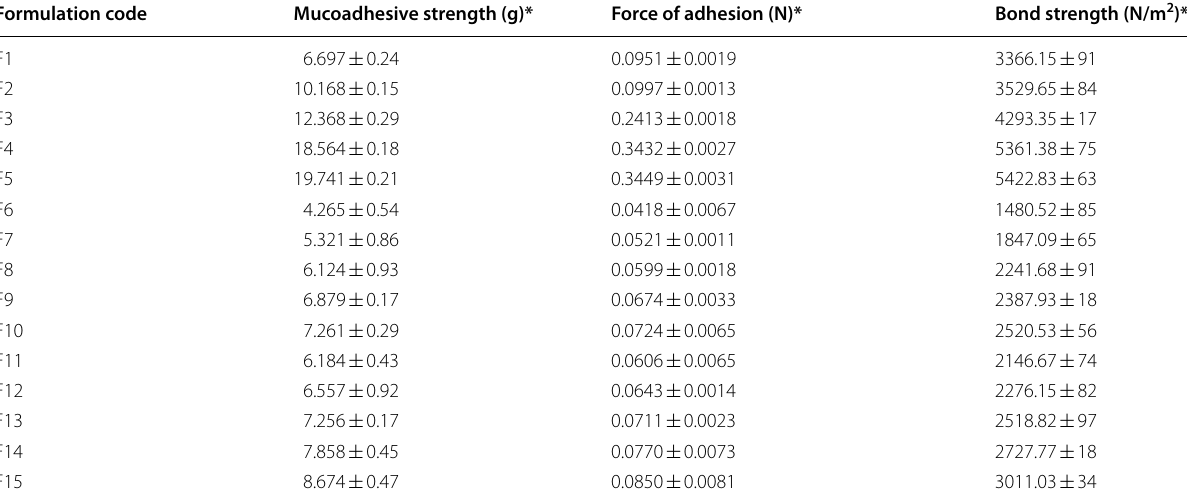
Table 5 Mucoadhesive strength results of the prepared mucoadhesive